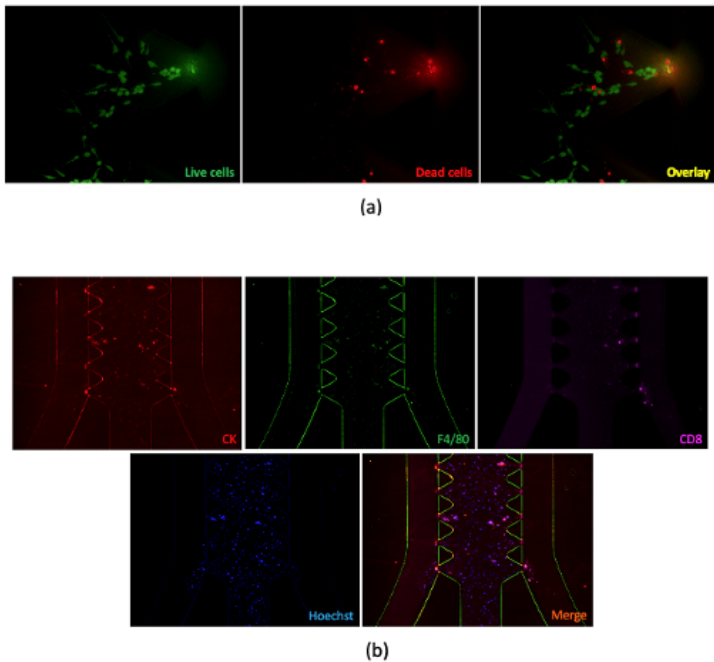
Figure 2. Examples of using immunofluorescence. ( a ) Live–dead cell staining for MC38 cell lines cultured in AIM 3D Chip. ( b ) Immunostaining of MC38-tumor-derived spheroids. Spheroids were stained with conjugated antibodies targeting panCK, CD4, and CD8 (overnight at 4 °C). Hoechst 33,342 was used to label nuclei. Images were taken using a fluorescence